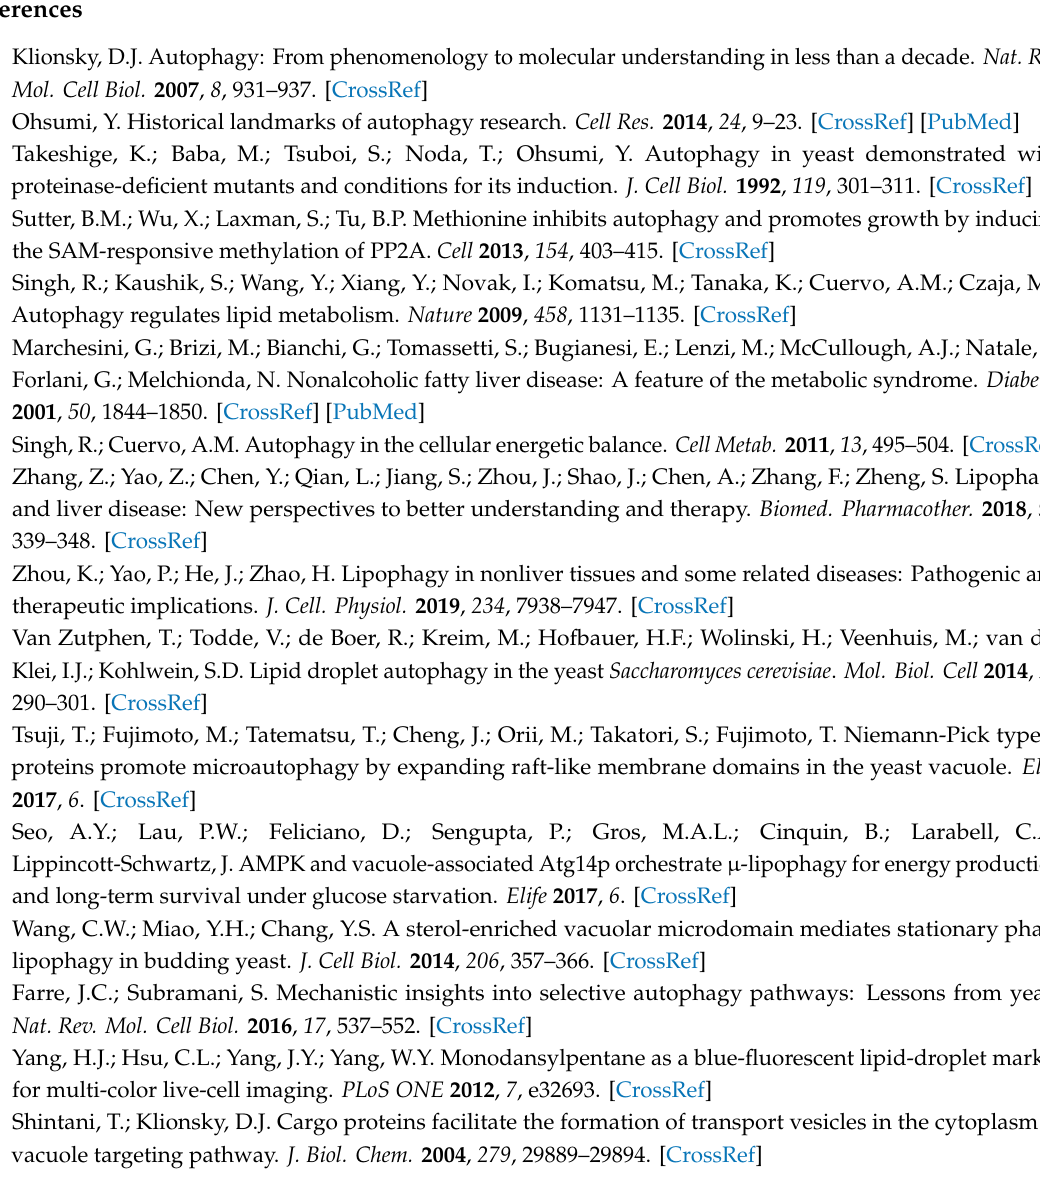
Figure A2. Supplemental figure for Figure 4a. Loading control (see Figure 4a for details).